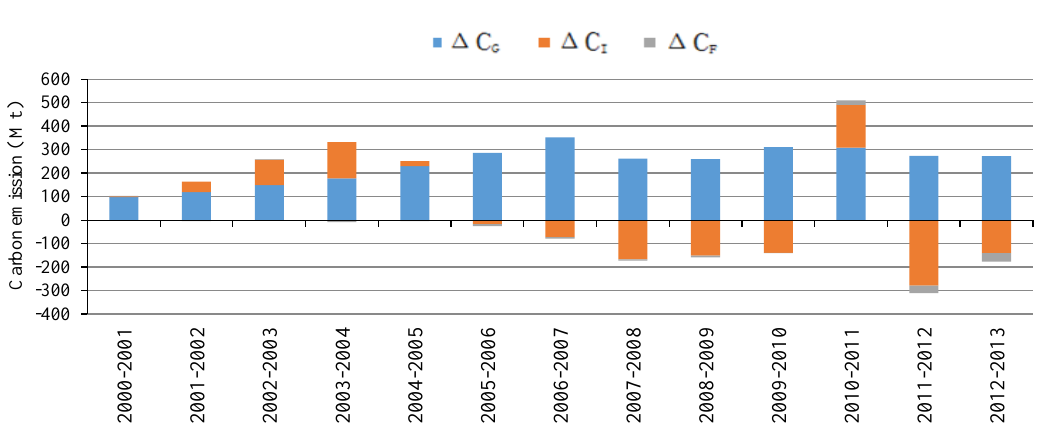
Figure 8. Decomposition of changes in CO 2 emissions for the whole group of 30 provincial power grids in China, 2000–2013.